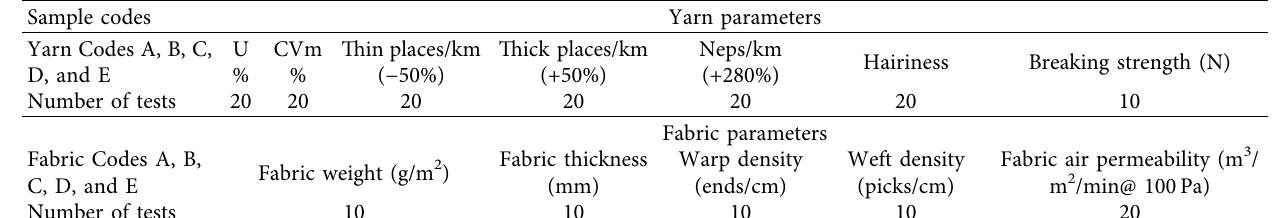
Table 1: Experimental design for the test.